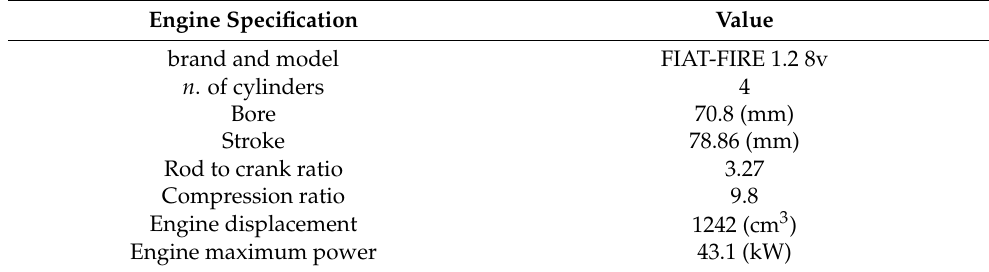
Table 1. Internal Combustion Engine (ICE)